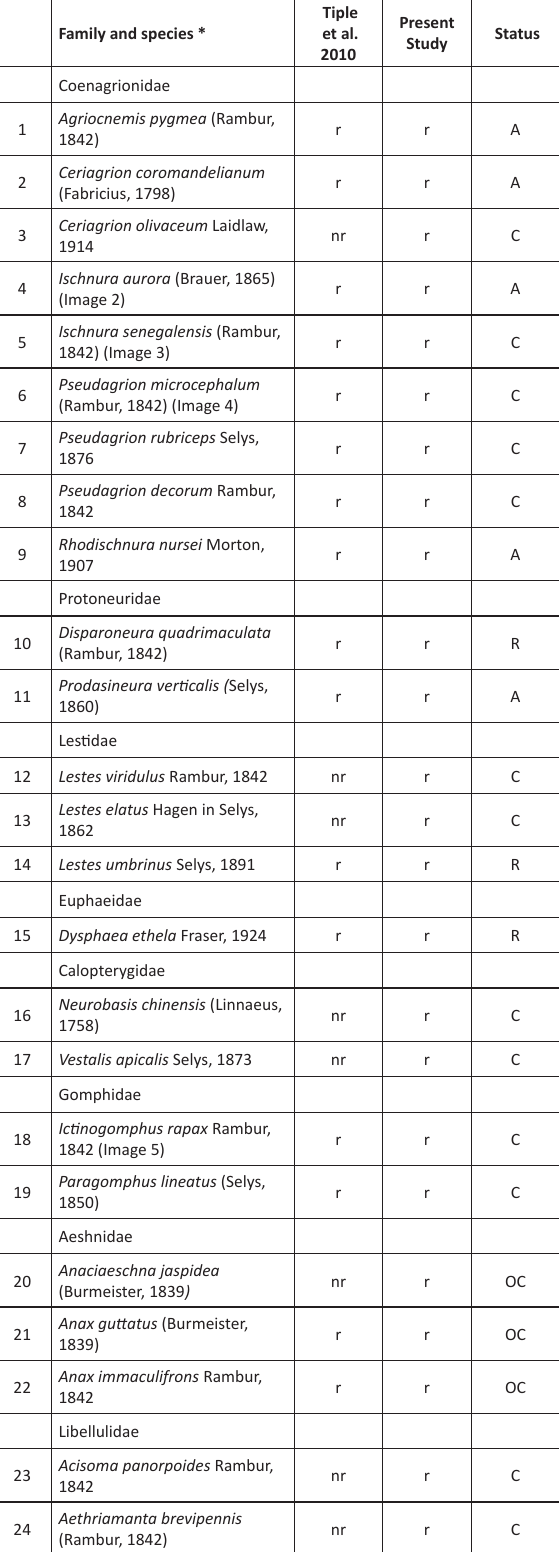
Table 1. Annotated checklist of odonates of Kanha Tiger Reserve, central India